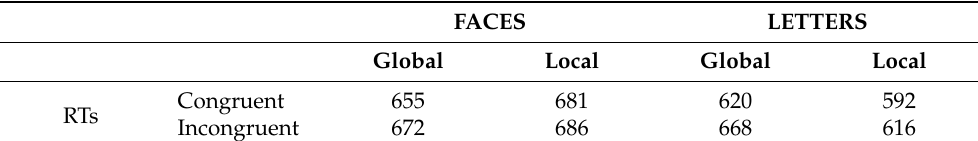
Table 1. Main results of Experiment 2 in terms of response times (ms) for the processing of faces and letters in the global and local conditions for congruent and incongruent stimuli.